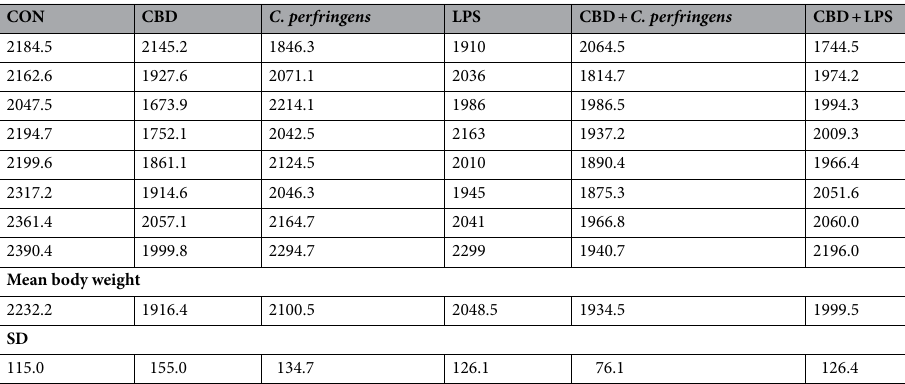
Table 4. Body weight (kg) of birds at 35 days of life. CON: received the basal diet over the entire period of the experiment and no challenge; CBD: received the CON diet supplemented (on top) with 30 g/kg Cannabis sativa extract; C. perfringens and LPS: received the CON diet and subjected to C. perfringens and E. coli LPS challenge, respectively; CBD + C. perfringens and CBD + LPS: received the CBD diet and subjected to C. perfringens and E. coli LPS challenge,